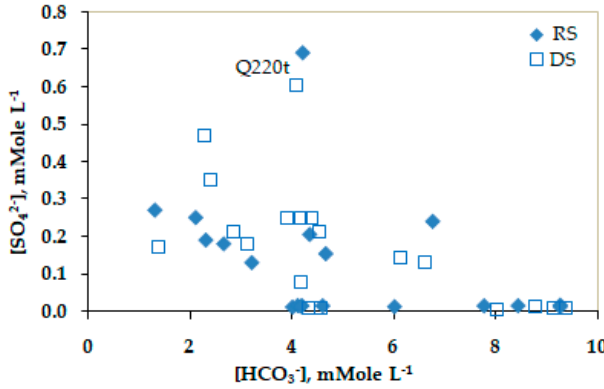
Figure 10. Scatter plot of molar [SO 42 − ] vs. [HCO 3 − ] for groundwater in both Holocene and Pleistocene aquifers showing the sulphate reduction led to lowering SO 42 − concentration in water.